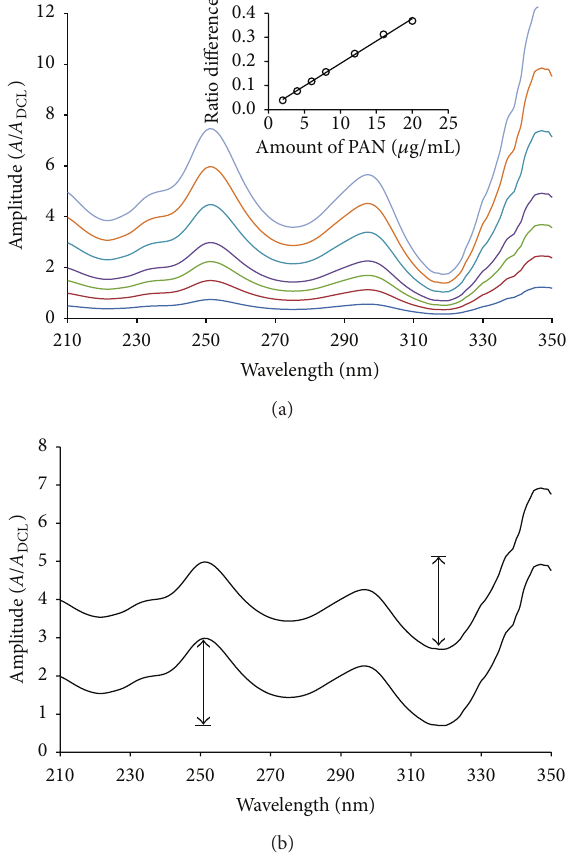
Figure 5: First derivative of ratio spectra of (a) 2.0–24.0 𝜇 g/mL diclofenac and (b) 2.0–20.0 𝜇 g/mL pantoprazole obtained using 4.0 𝜇 g/mL pantoprazole and diclofenac as a divisor, respectively, and methanol as a